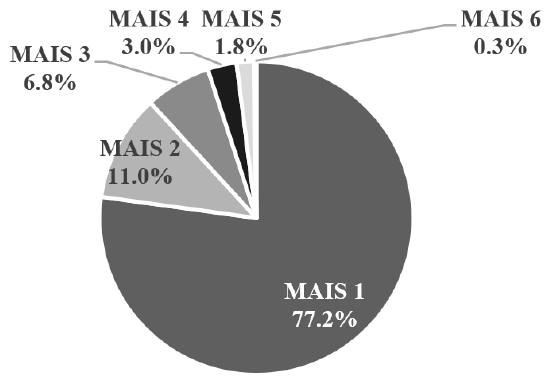
Figure 2. The maximum abbreviated injury severity (MAIS) score distribution for all pregnant women. Table 1. Comparison of the background and collision characteristics of pregnant women with a MAIS of one (n = 568) or two or more (n =